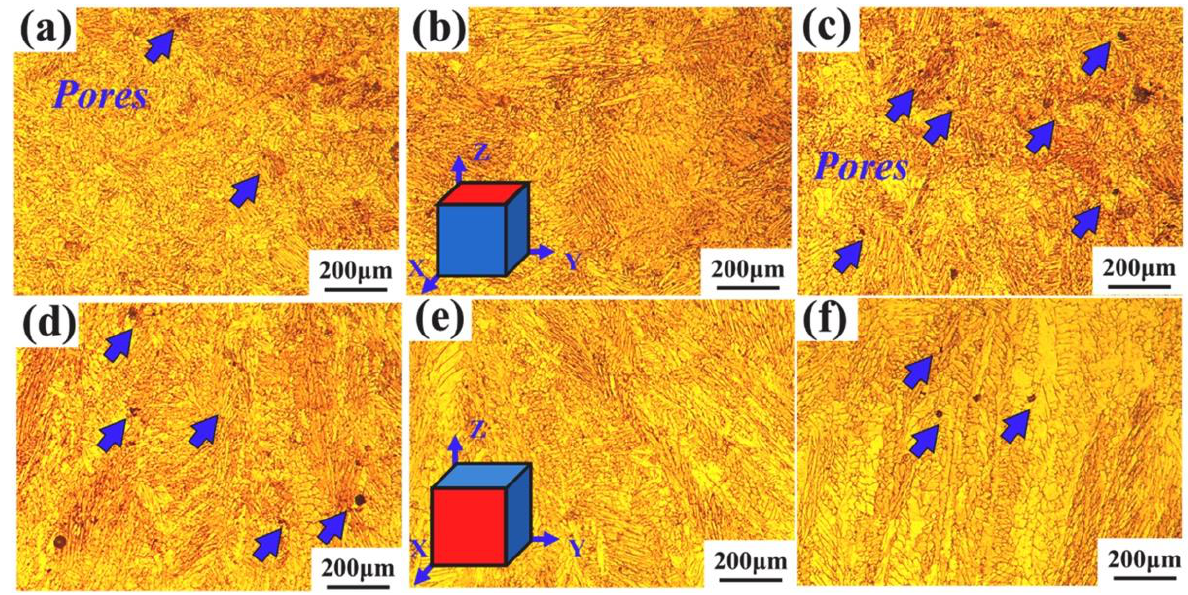
Figure 3. Surface morphology of LC of 17-4 PH stainless steel on E355DD steel for three different laser powers, XY plane, ( a ) 2000 W, ( b ) 2200 W, and ( c ) 2400 W, YZ plane, ( d ) 2000 W, ( e ) 2200 W, and ( f ) 2400 W. Reproduced with permission from [23]. Copyright Elsevier, 2022.